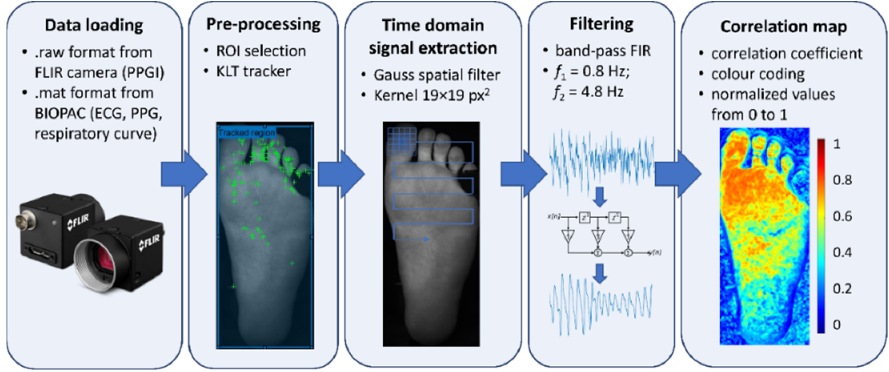
Figure 3. Data processing steps. Ordered from the left, stage 1 to stage 5.